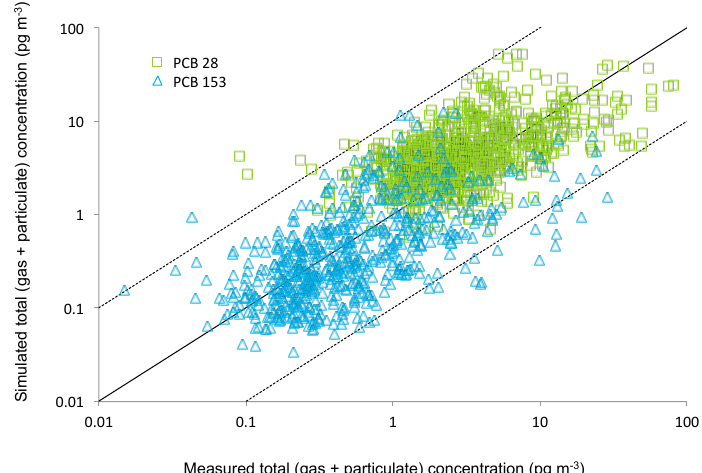
Figure 2. Comparison of seasonal averages of simulated and measured total concentrations of CBs 28 and 153. Measurement data come from 23 different non-urban monitoring sites in the Northern Hemisphere, which correspond to 21 different GEOS-Chem grid boxes. The solid line represents a 1:1 relationship, while the dashed lines represent the boundaries where simulated concentrations are 0.1 and 10 times measured